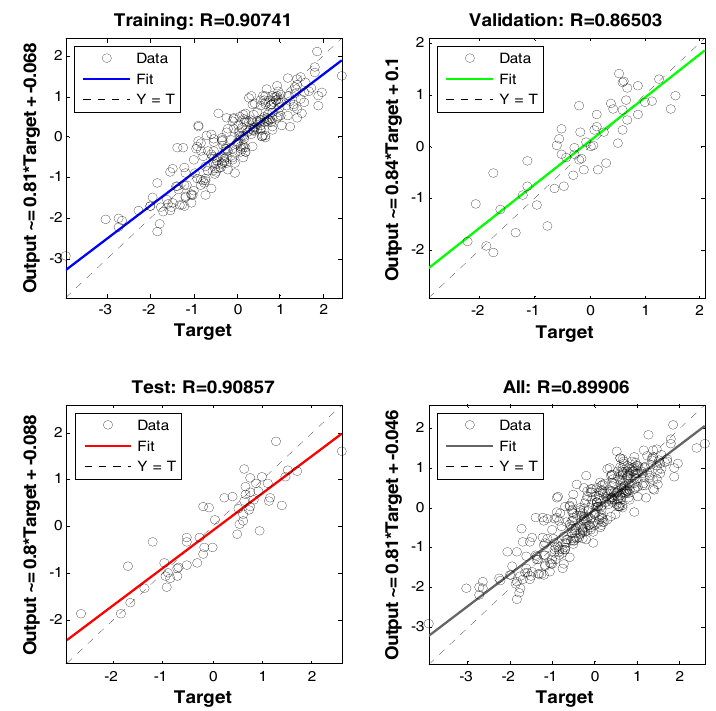
Figure 8. Neural network training regression for input model 1.